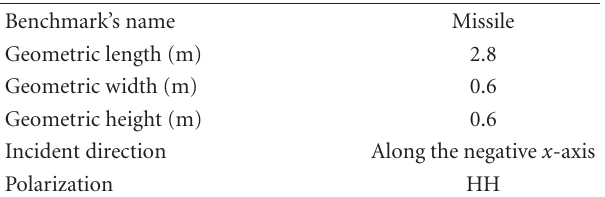
Figure 14: Surface current distribution of the missile. Table 4: Parameters of the model.